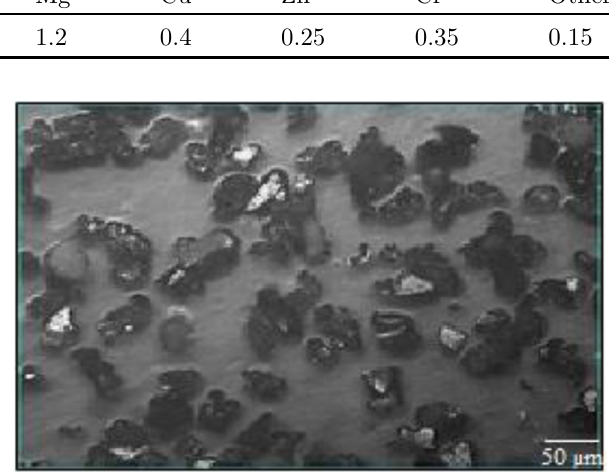
Fig. 1. SEM micrograph of Silicon carbide